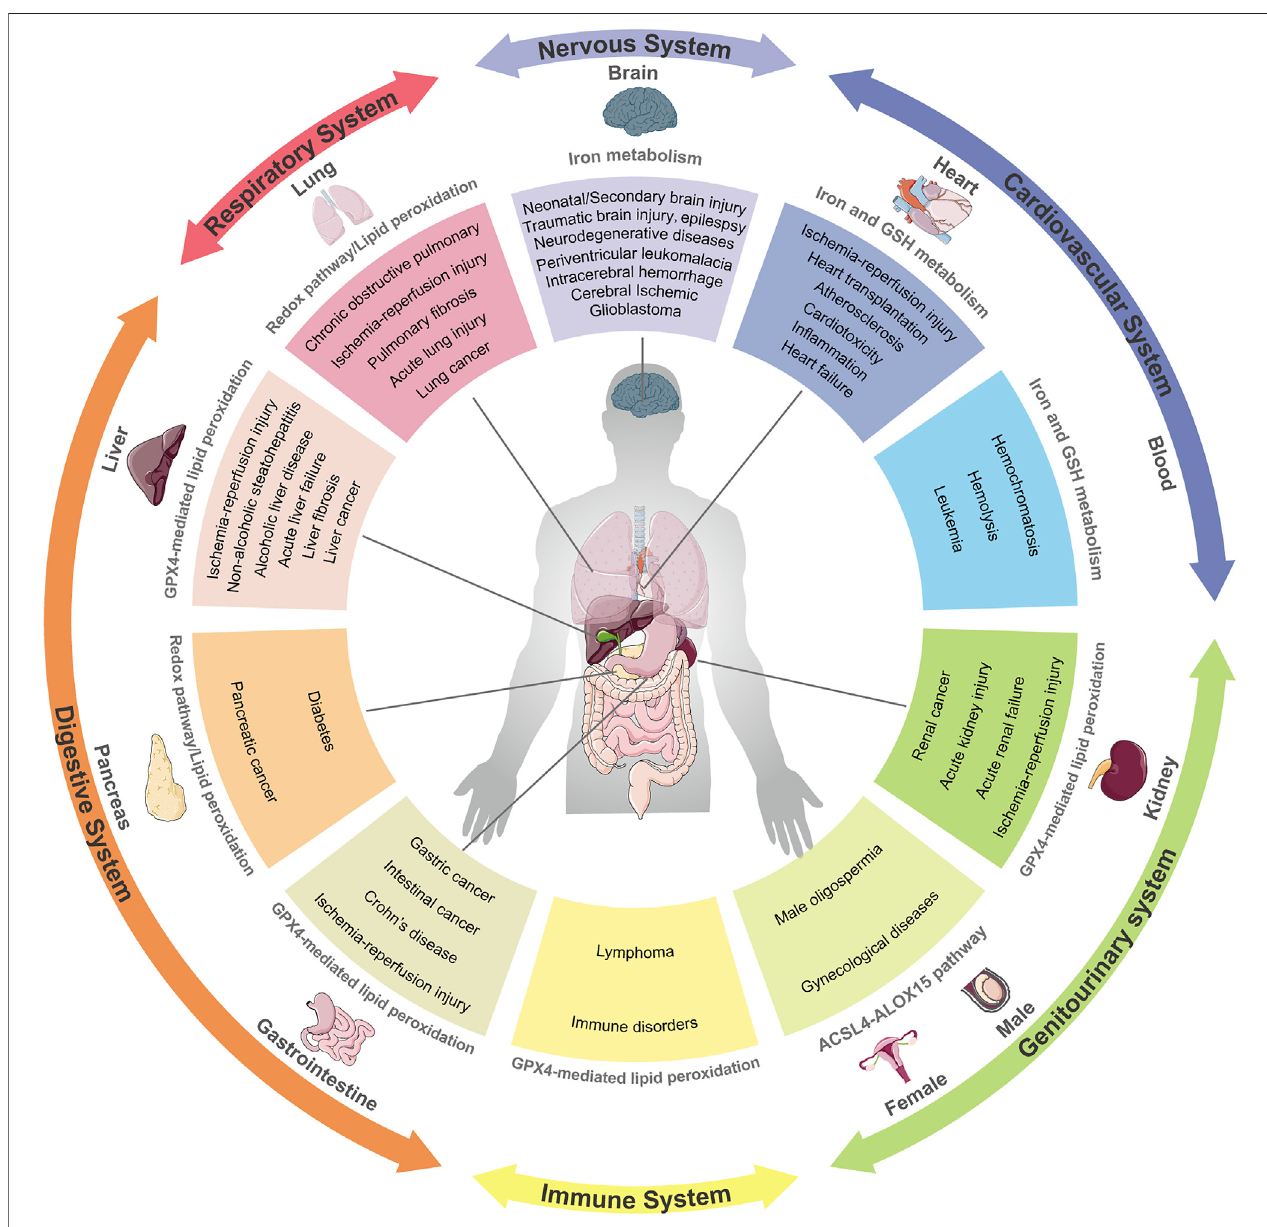
FIGURE 3 | Ferroptosis and its implication in different pathophysiological contexts. Ferroptosis has been linked to pathological processes in diverse human body systems,including thenervoussystem,digestivesystem,respiratorysystem,circulatorysystemandurinarysystem.Abnormal pathwaysthatcontributetodiseasesare recapitulatively